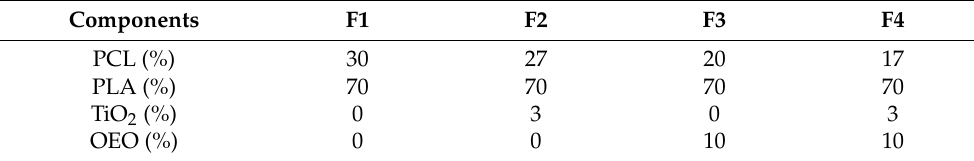
Table 1. Formulations used for forming PCL/PLA/TiO 2 /OEO membranes